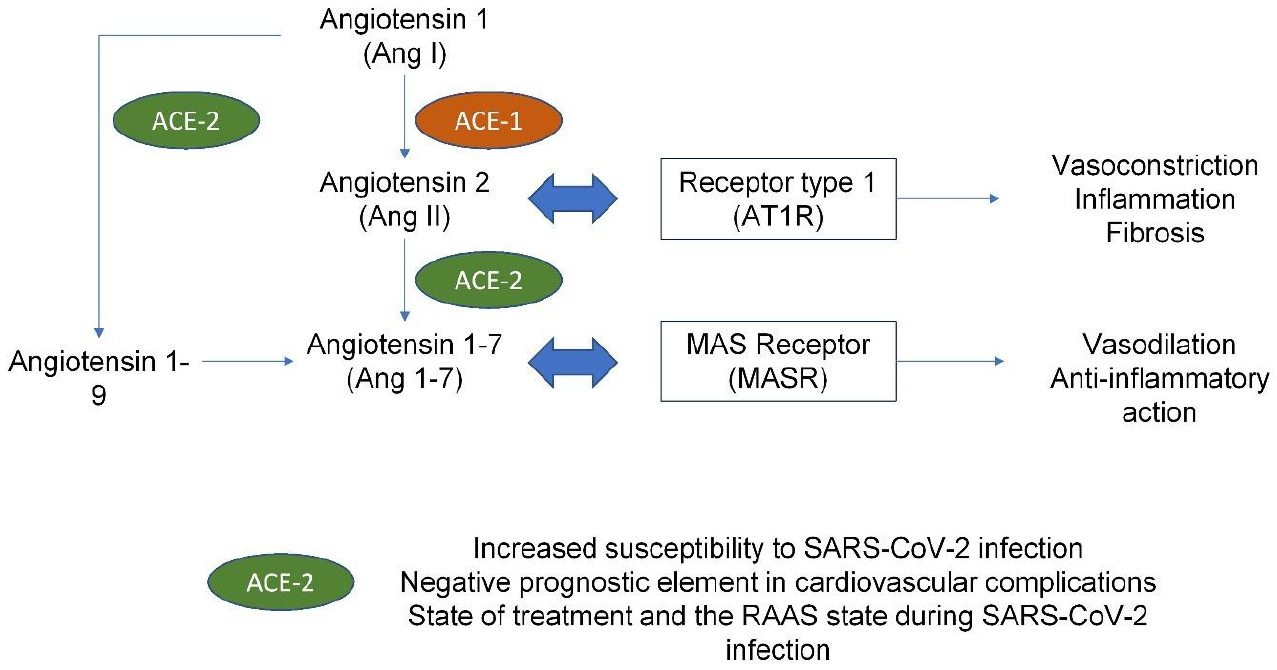
Figure 3. Renin–angiotensin–aldosterone system: summary of pathophysiologic effects and its im- portance in SARS-CoV-2 infection. Abbreviations: ACE: angiotensin-converting enzyme, type 1 or type 2; AT1R: angiotensin receptor type 1; MASR mitochondrial assembly receptor; RAAS: renin– angiotensin–aldosterone system; SARS-CoV-2: severe acute respiratory syndrome coronavirus 2.